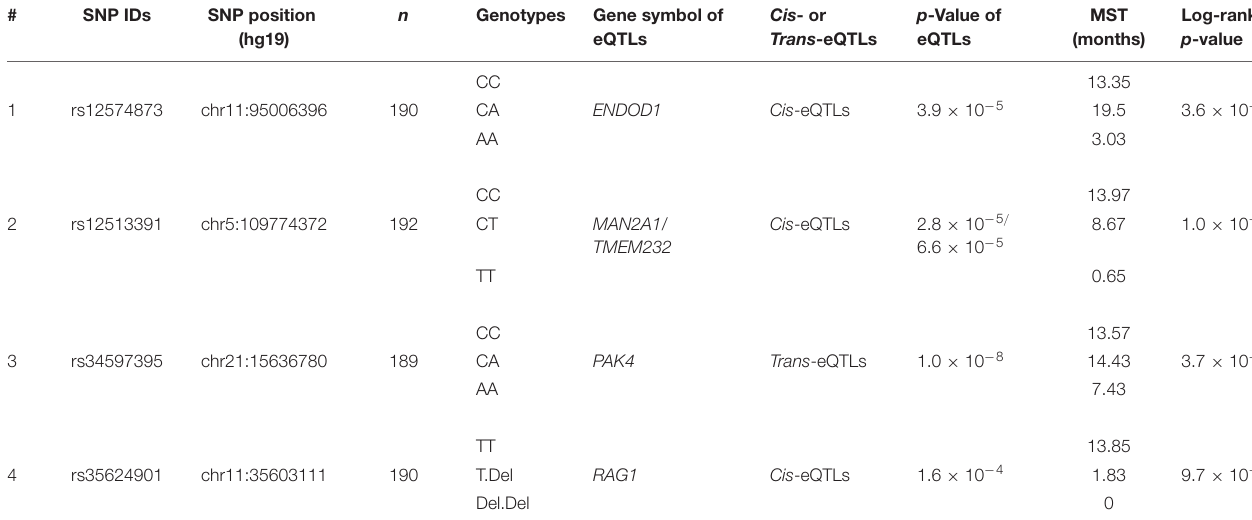
TABLE 3 | PancanQTL-identified genetic variants significantly associated with OS of TCGA LIHC